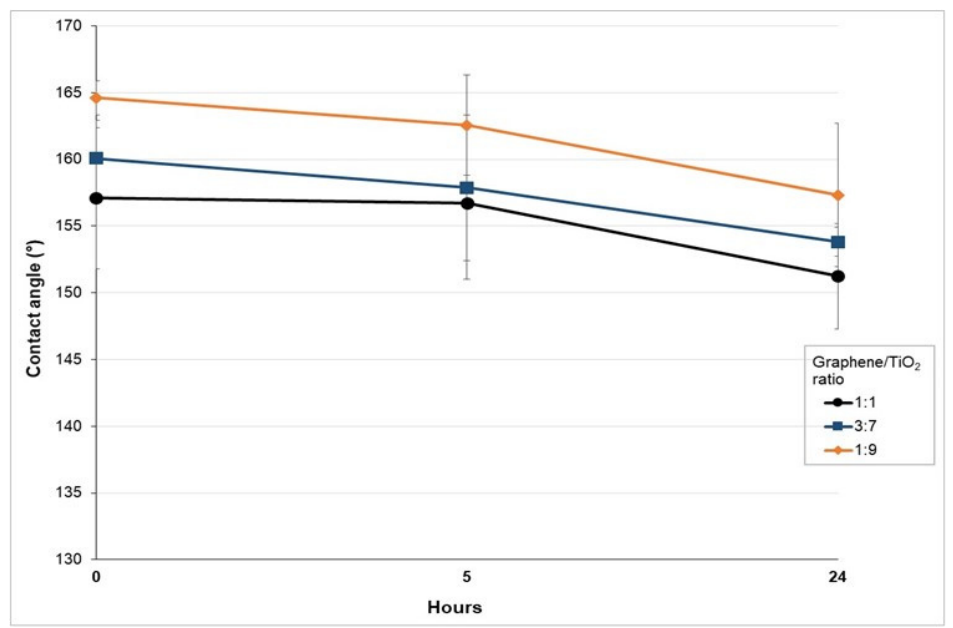
Figure 6. The durability of the superhydrophobic graphene/TiO 2 -coated films via contact-angle measurement upon water immersion for 5 h and 24 h.